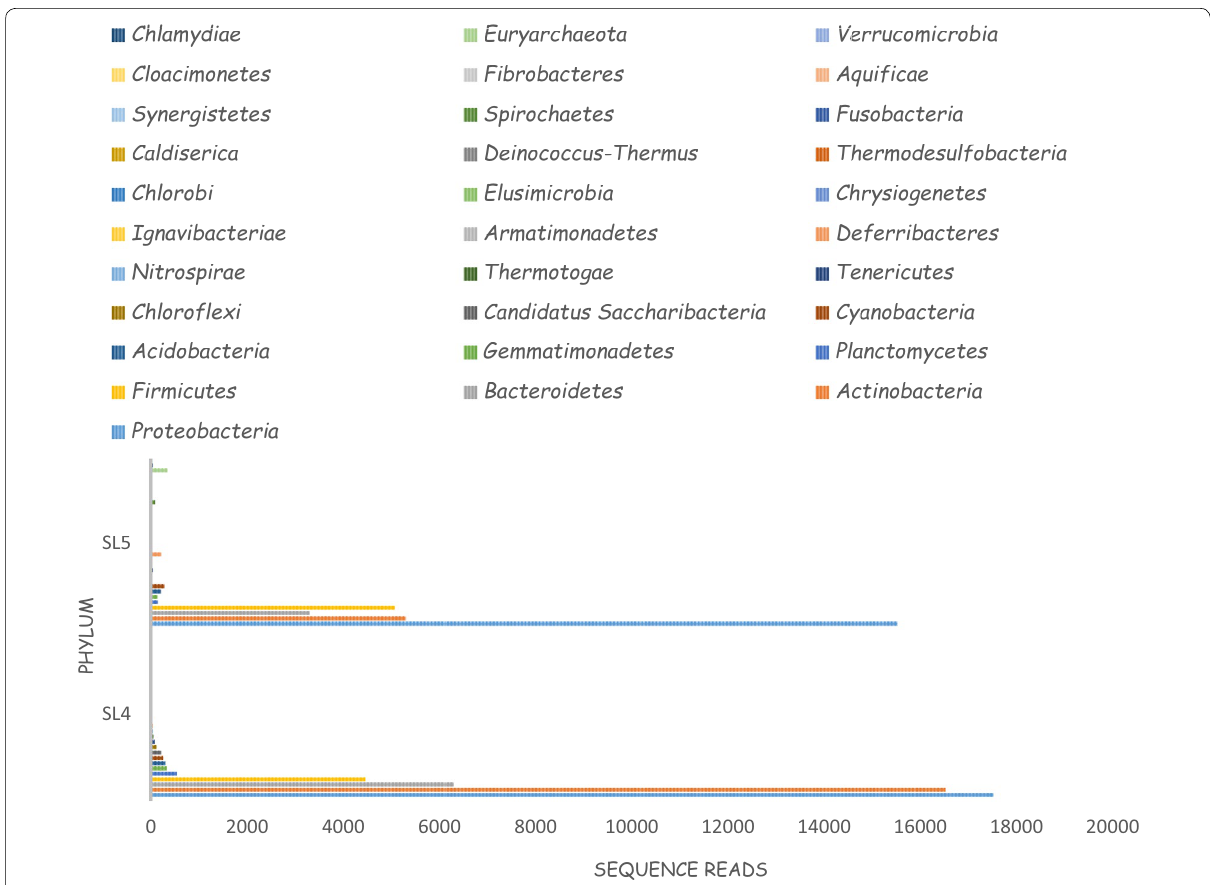
Fig. 1 Comparative taxonomic profile of SL4 and SL5 metagenomes at phylum level, computed by EDGE Bioinformatics. Unclassified reads were not used for the analysis. All the phyla detected in SL4 and SL5 metagenomes were